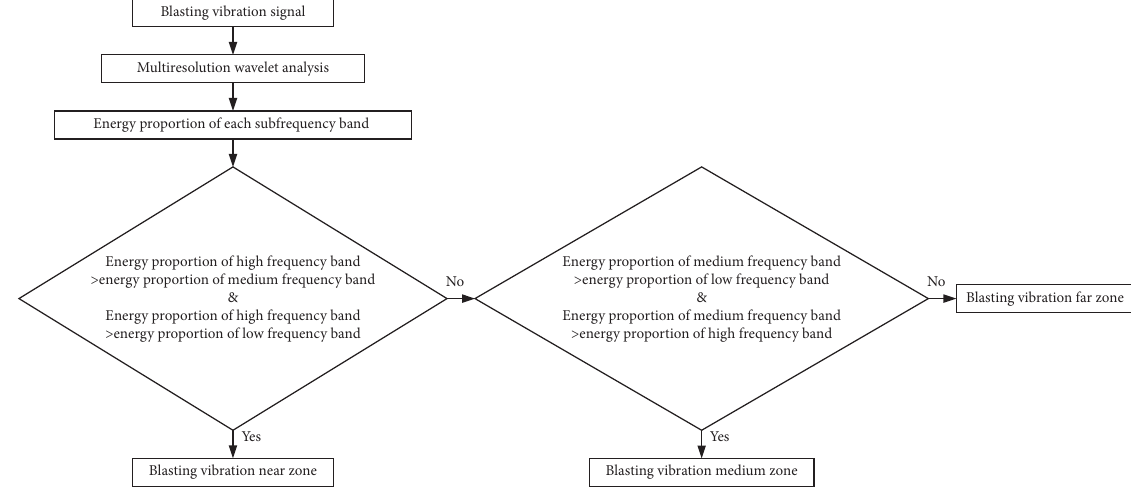
Figure 1: Flowchart of the zoning method of blasting vibration based on energy